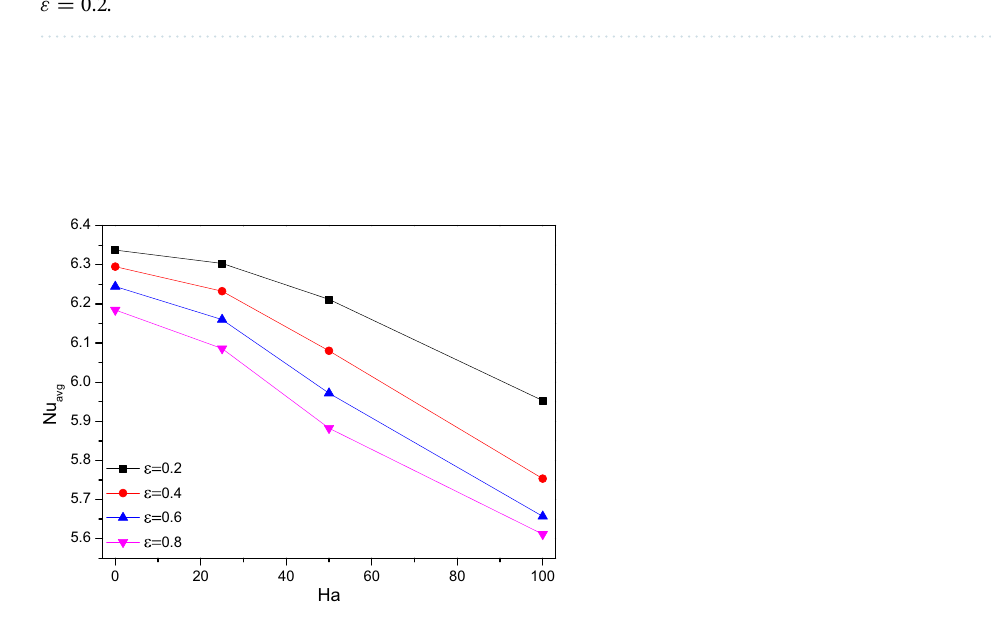
Figure 11. Variations of Nu avg with Ha for diverse ω when Ra = 10 6 , Da = 0.01 , φ = 0.02 , N = 4 , r = 0.1 and ε = 0.2 .